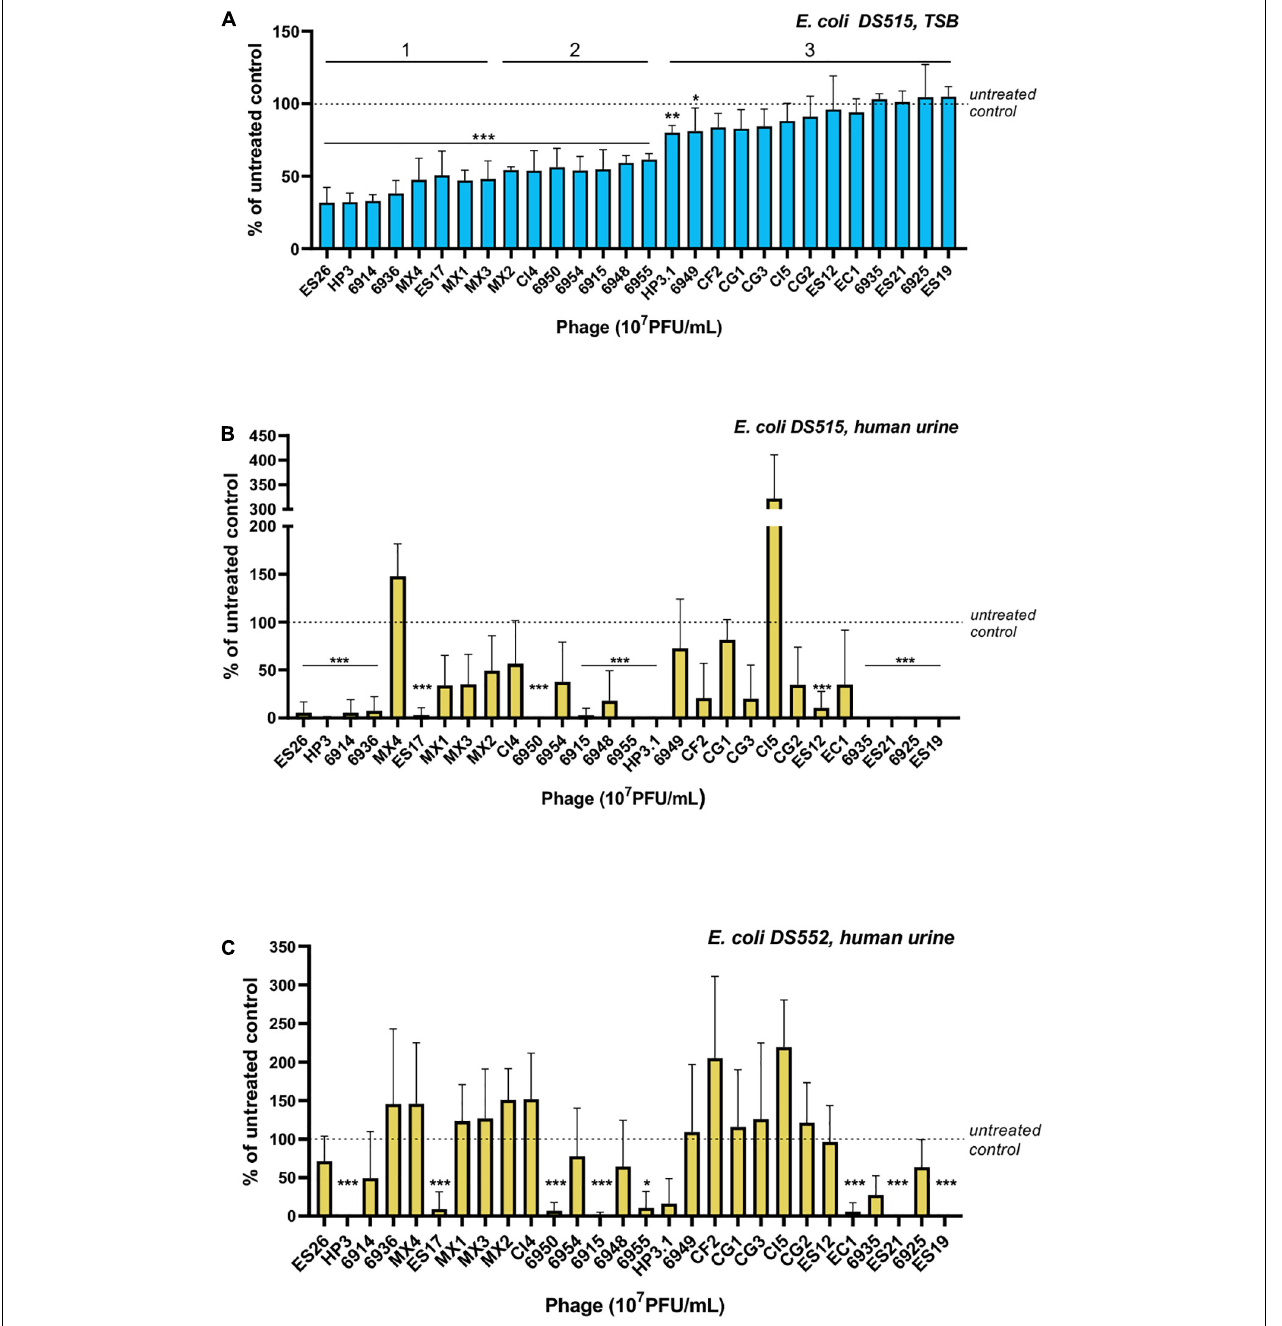
FIGURE 2 | Screens of E. coli phage for anti-biofilm activity. Viability of cells in the biofilm under each condition after 24-h treatment with 10 7 PFU/mL of phage is represented as a percentage of the untreated control. E. coli DS515 biofilms in TSB (A) and human urine (B) , and E. coli DS552 biofilms in human urine (C) are shown. Phage were classified into groups 1, 2, and 3, based on their high, intermediate, or low/no anti-biofilm activity. *** p < 0.001, ** p < 0.01, * p <